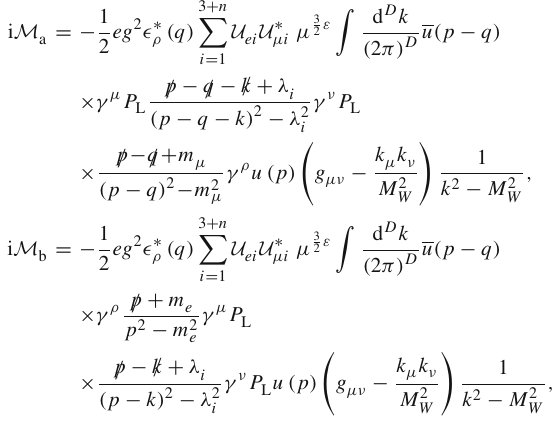
where (α, β) = ( e , μ) , (μ, τ) or (τ, e ) and ( i , j ) = ( 1 , 2 ) , ( 2 , 3 ) or ( 3 , 1 ) , and their differences signify slight unitarity violation of the 3 × 3 PMNS matrix U